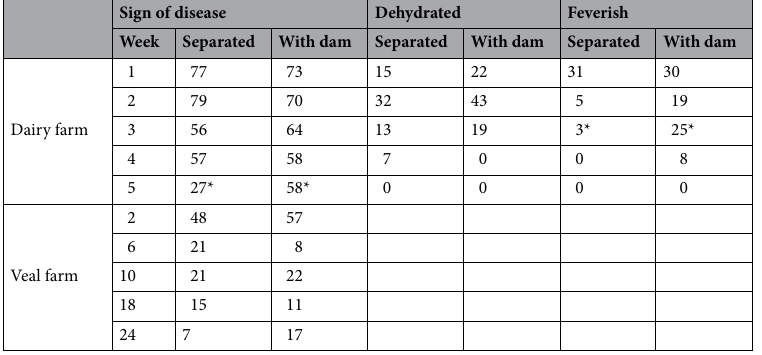
Week Separated With dam Separated With dam Separated With dam